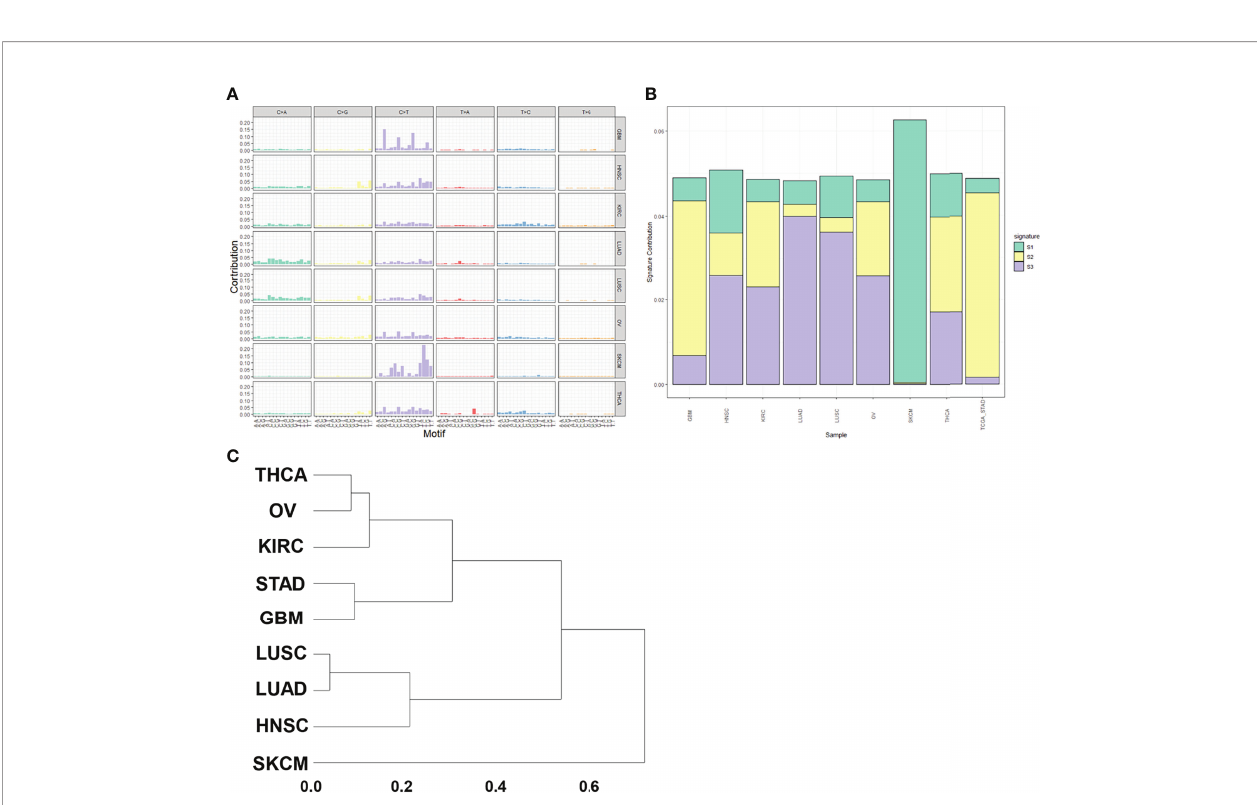
FIGURE 8 | Pan-cancer analysis. (A) Mutation spectrum of pan-cancer samples. (B) Mutation feature ratio distribution. (C) Mutation feature